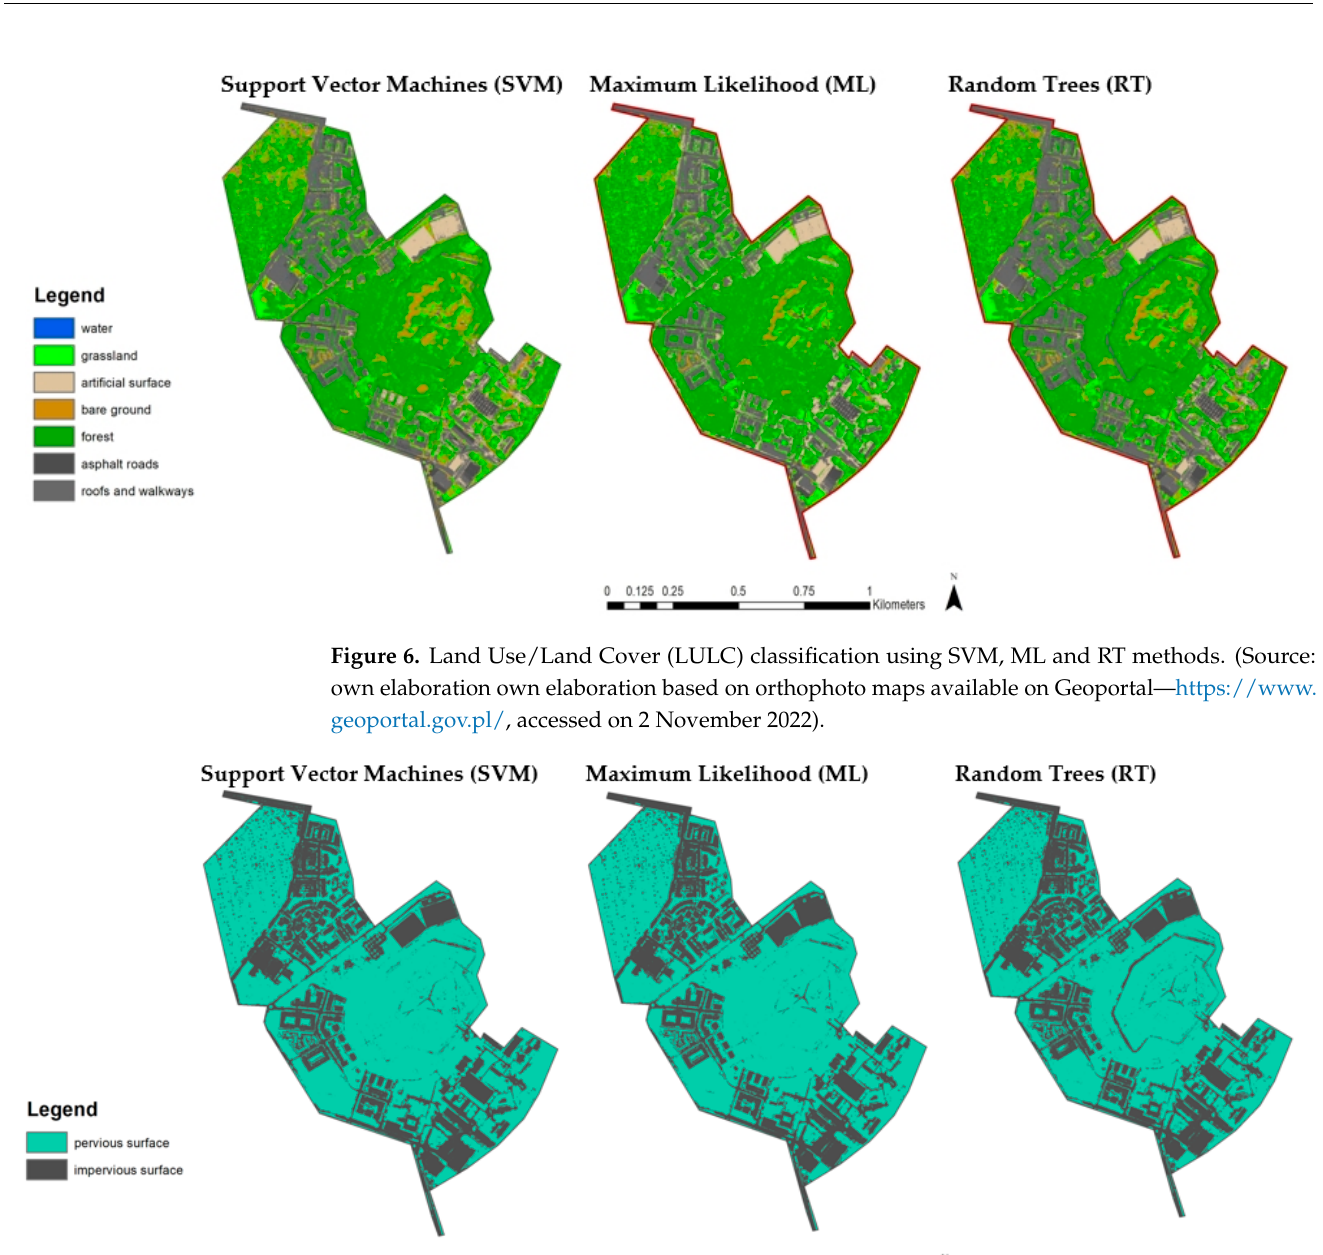
Table 1. Confussion Matrix (SVM method).